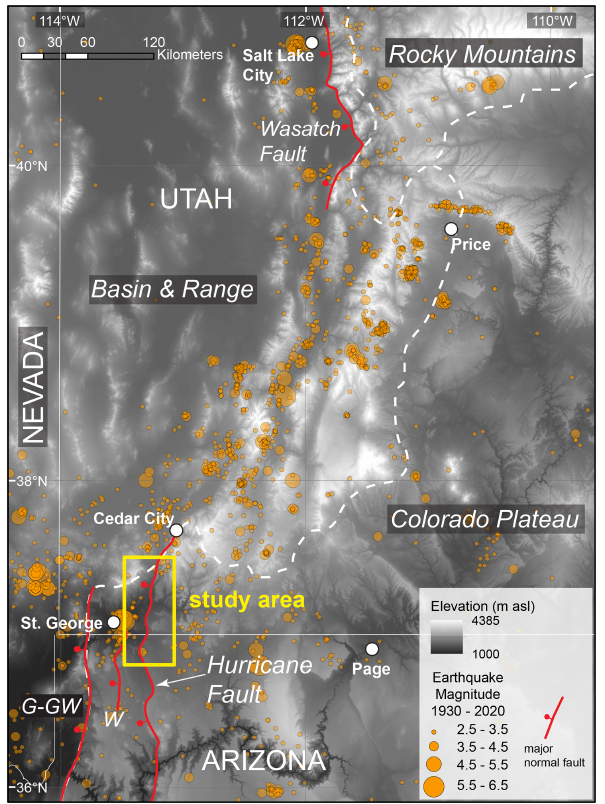
Figure 1. Location of the Hurricane fault and study area along the boundary between the Colorado Plateau and the Basin and Range tectonic provinces in the western USA. The fault is located within the Intermountain Seismic Belt as delineated by the depicted > M2.5 earthquakes recorded between 1930 and 2020 (USGS, 2020). Other notable faults in the region include the Gunlock– Grand Wash (G–GW) and Wasatch faults. (Digital elevation, SRTM 1 Arc-Second Global https://doi.org/10.5066/F7PR7TFT, courtesy of the U.S. Geological